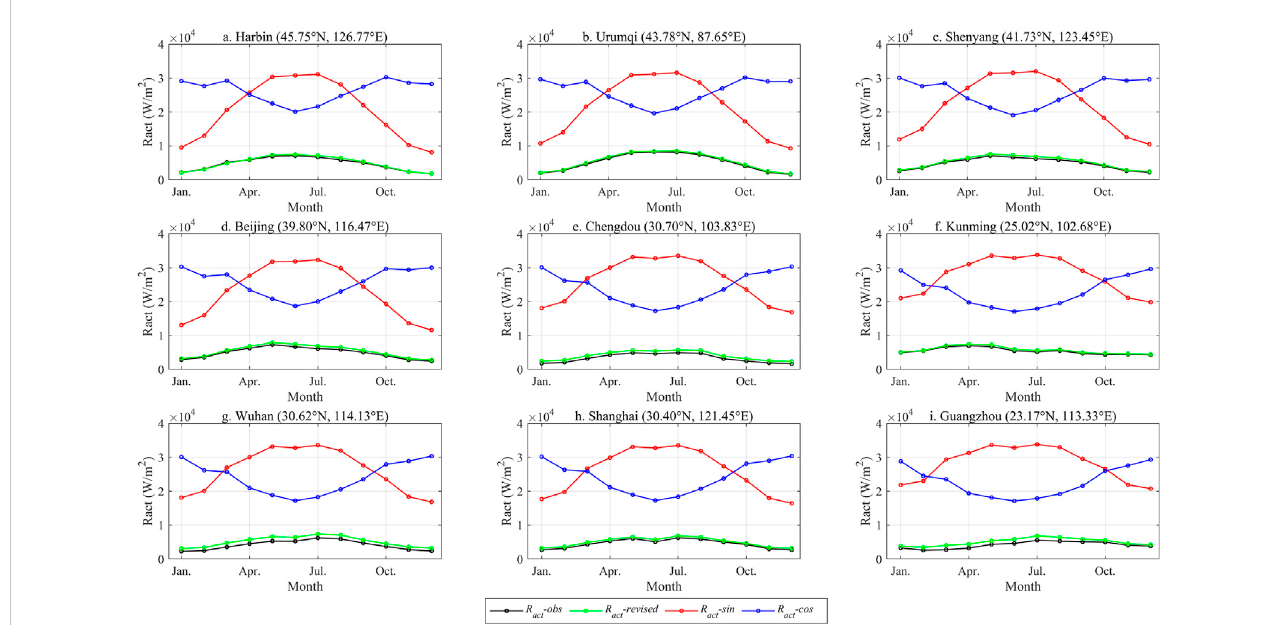
FIGURE 2 Comparative results of monthly R act calculated by three methods. Lables (A – I) represent nine cities, Harbin, Urumqi, Shenyang, Beijing, Chengdu, Kunming, Wuhan, Shanghai, Guangzhou, respectively.